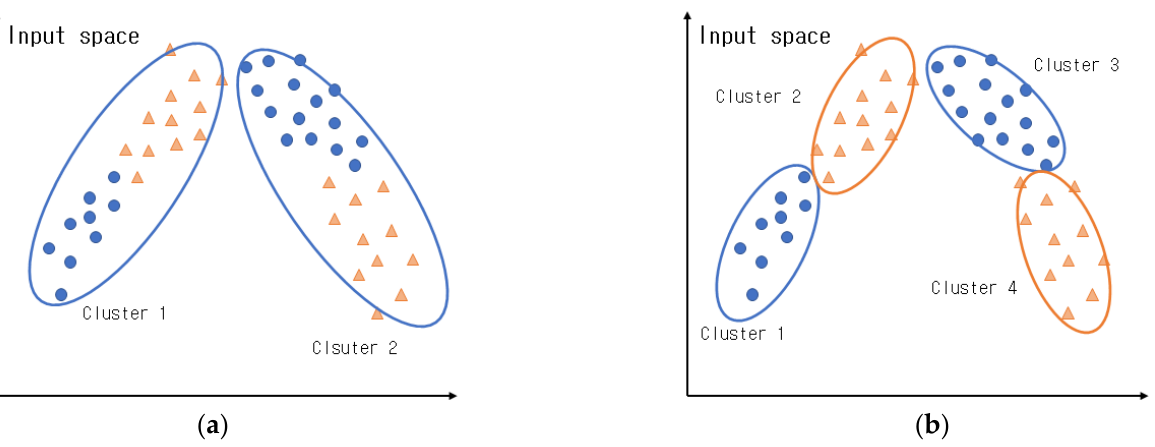
Figure 8. Comparison of clusters created in GK and CGK clustering: ( a ) general GK clustering; ( b ) context-based GK clustering.